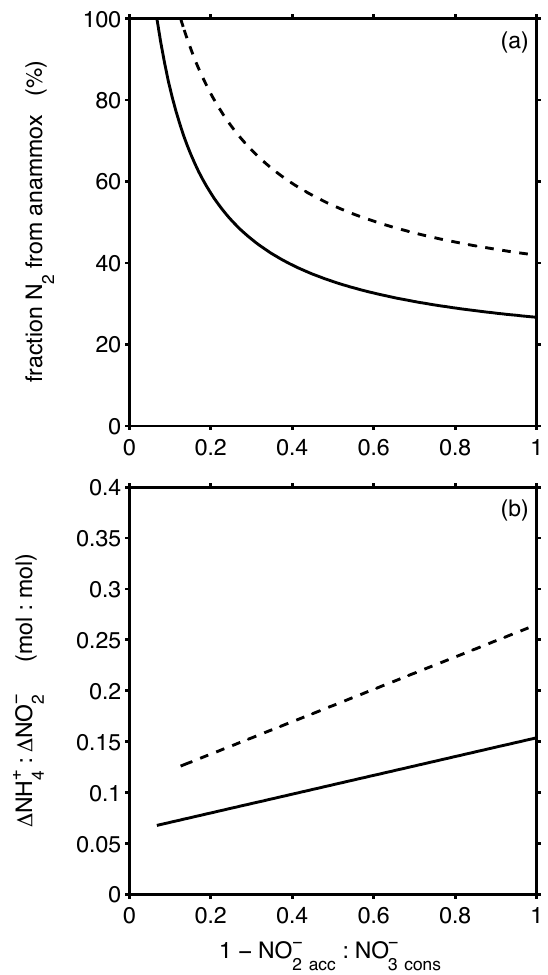
Fig. 1. Scenario I, assuming that suboxic N-conversions are due to a combination of DNRN, denitrification and anammox such that no NH + but variable fractions of NO − accumulate. On the x-axes 4 2 we plot the property “1 – NO − : NO − ”. We 2 accumulated 3 − consumed interpret this property as the efficiency of the overall N-conversion process where the value of one represents the condition of a fully efficient conversion of NO − to N 2 (i.e. all NO − is used up). Solid 3 2 lines are for a mean composition of respired organic matter of C 106 H 175 O 42 N 16 P (Anderson, 1995), dashed lines for respiration of pure proteins (C 3 . 83 H 6 . 05 O 1 . 25 N, Laws, 1991; Anderson, 1995). (a) Fraction (in percent) of total N 2 -production which is due to anammox. In the combined reactions of scenario I the remainder to 100 percent is due to denitrification. (b) Ratio of production rates of NH + and NO − (mol:mol) during the coupled reactions of 4 2 DNRN (providing NH + and NO − ) and denitrification (providing 4 2 NH + only) for the given boundary conditions (no NH + accumula- 4 4 tion) and the respective efficiencies of the overall N-conversion pro- cess (x-axes). Note that this ratio is always well below one, the sto- ichiometric ratio of NH + and NO − in anammox, indicating NH + 4 2 4 limitation of